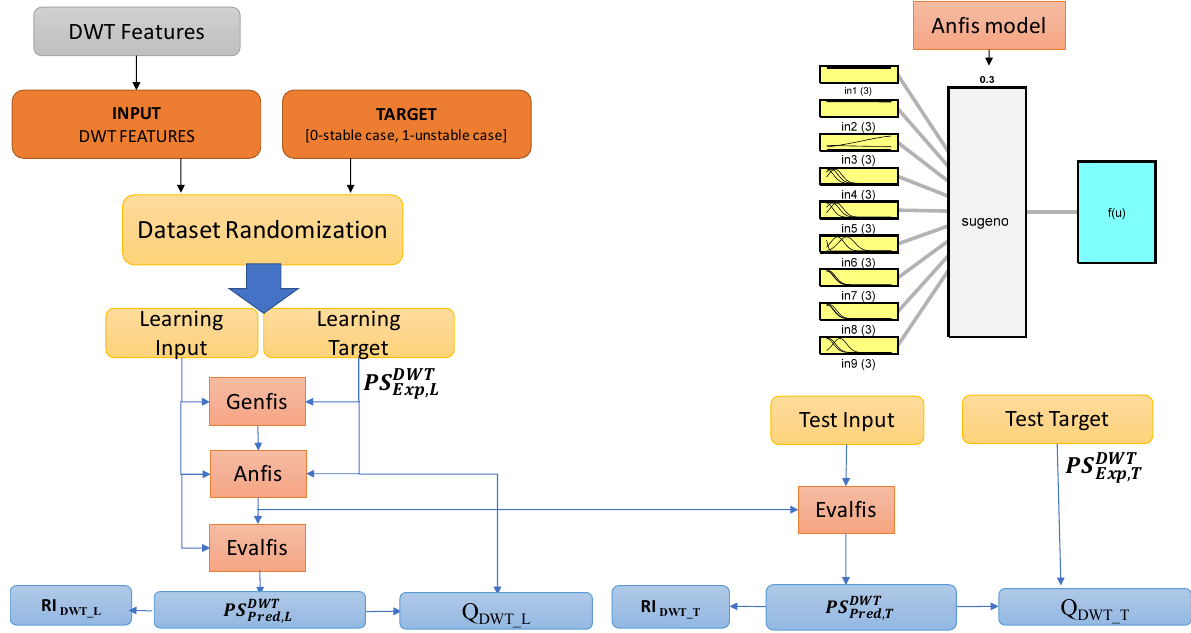
Figure 3. The Neuro-Fuzzy inference system considered in this work to analyze the postural sway and to detect potential unstable behaviors [39].